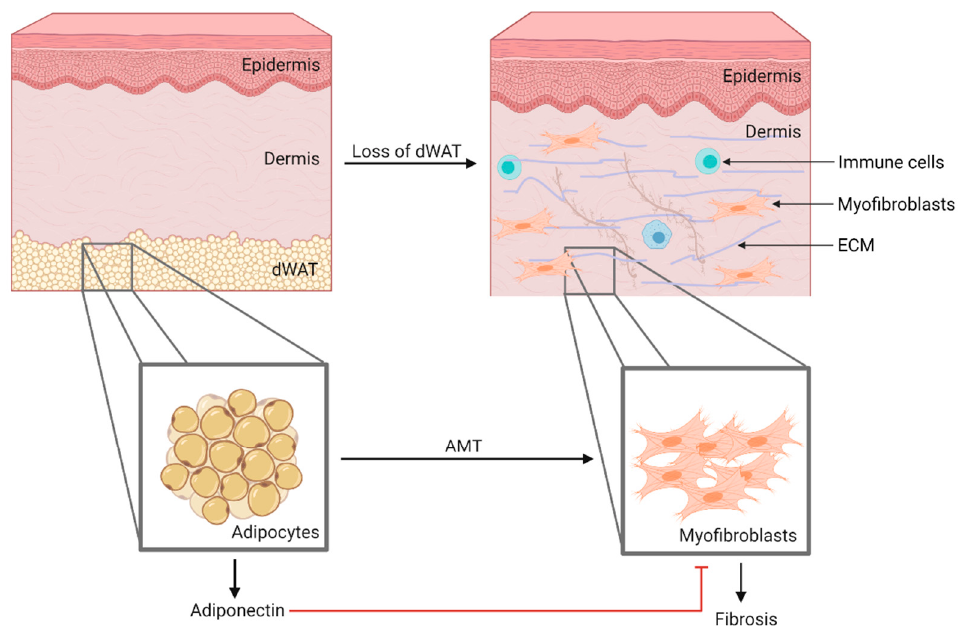
Figure 4. Local loss of dWAT in SSc skin in addition to adipocytes undergoing AMT causes decreased adiponectin secretion. Consequently, its inhibitory effects on myofibroblasts are lost, which results in fibrosis. AMT: adipocyte mesenchymal transition, dWAT: dermal white adipose tissue, EMC: Extracellular matrix, SSc: Systemic sclerosis.